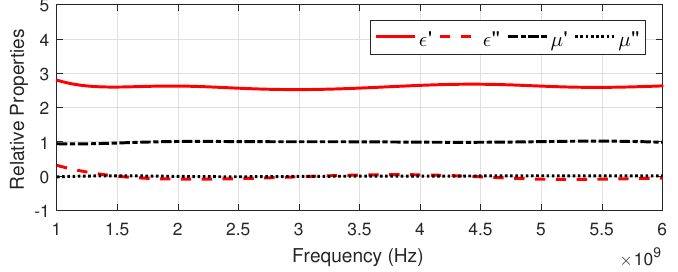
Figure 13. The properties of PMMA extracted by the NRW using experimental data with r = 48